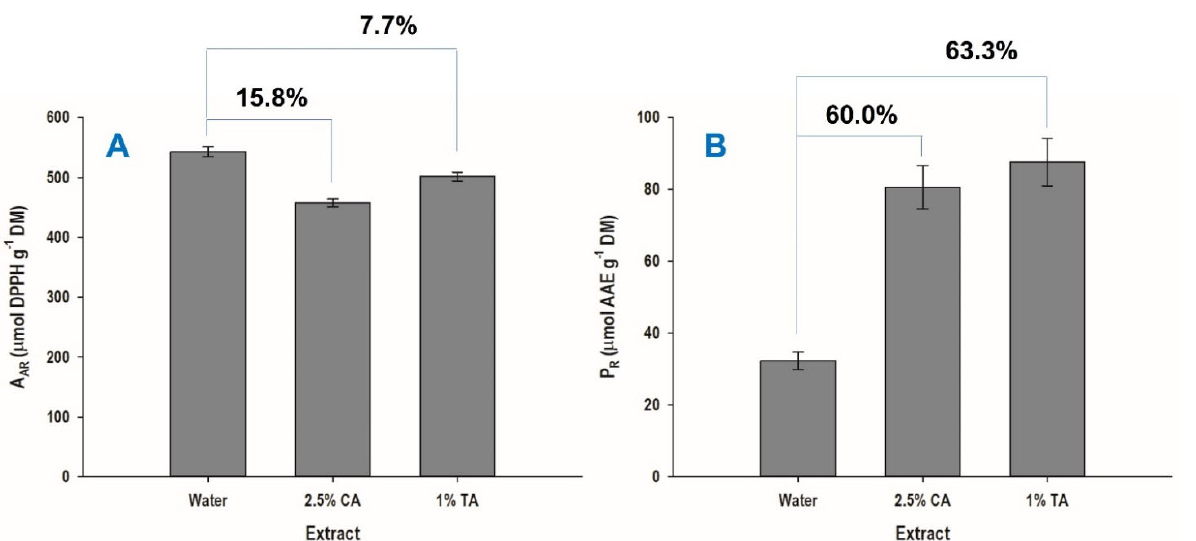
Figure 7. Antiradical activity (A AR ) ( A ) and ferric ‐ reducing power (P R ) ( B ) of WOP extracts. All ex ‐ tracts were produced at 55 °C, for 60 min. TA and CA denote tartaric and citric acid,